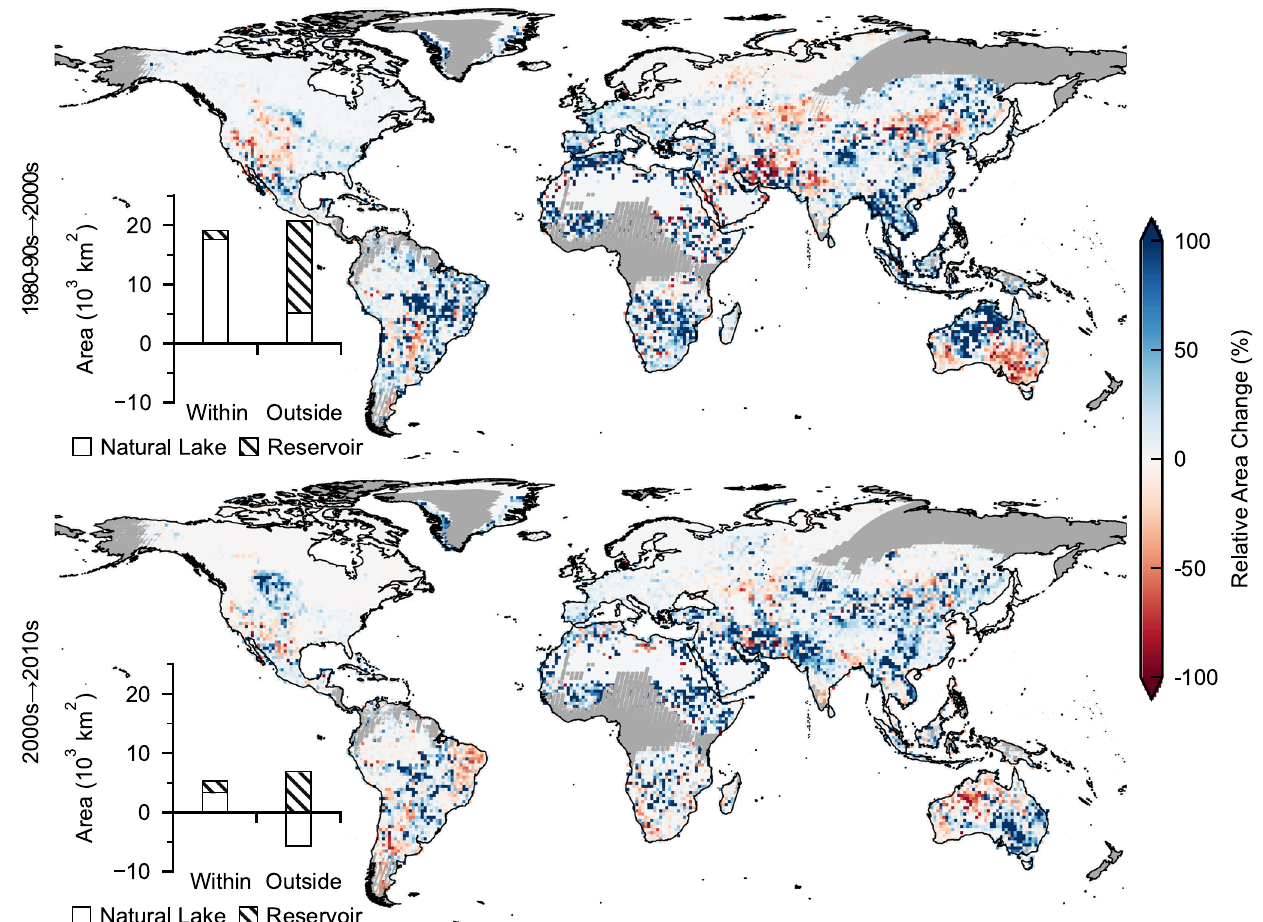
Fig. 2 | Lake area changes across different periods (1980 – 1990s, 2000s, and 2010s). Datawereaggregatedinto1°×1°gridcells.Thegrayareasindicateregions withinsuf fi cientsatellitecoverageintheearlyperiods;theseregionswereexcluded